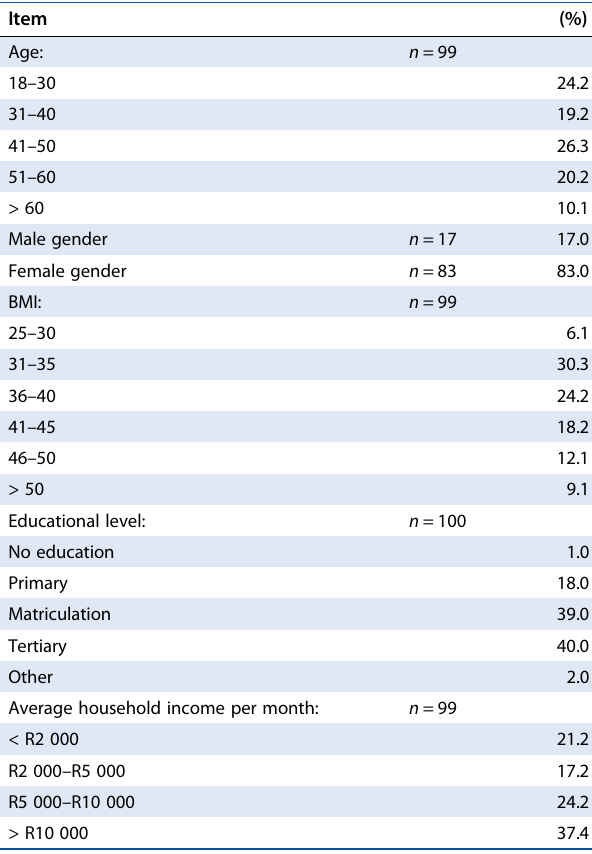
Table 1: Sociodemographic characteristics of the participants Table 2: Frequency results on perceptions, knowledge, attitudes and eating